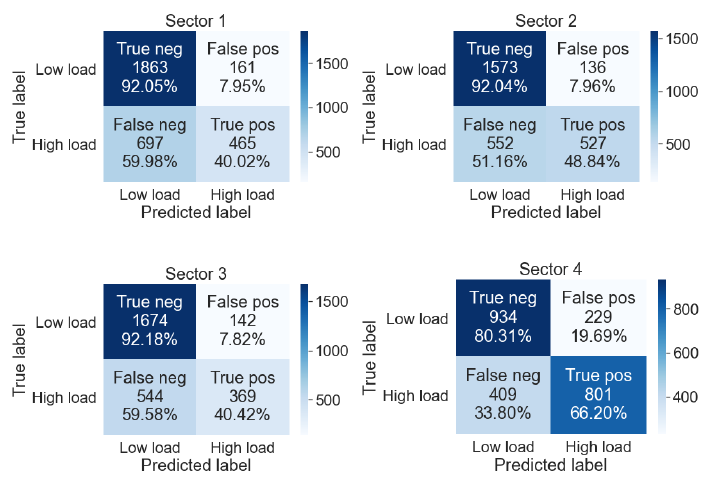
Figure 13. Confusion matrices for each